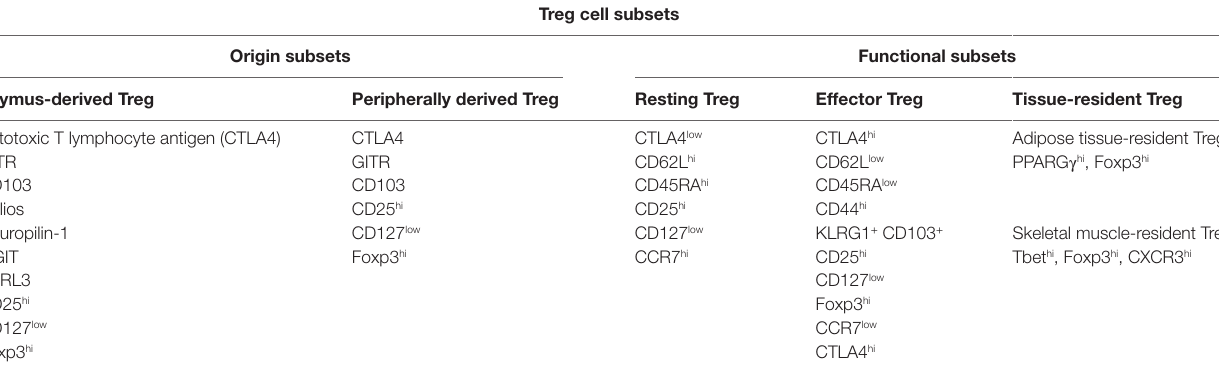
TABLe 1 | Markers for Treg cell